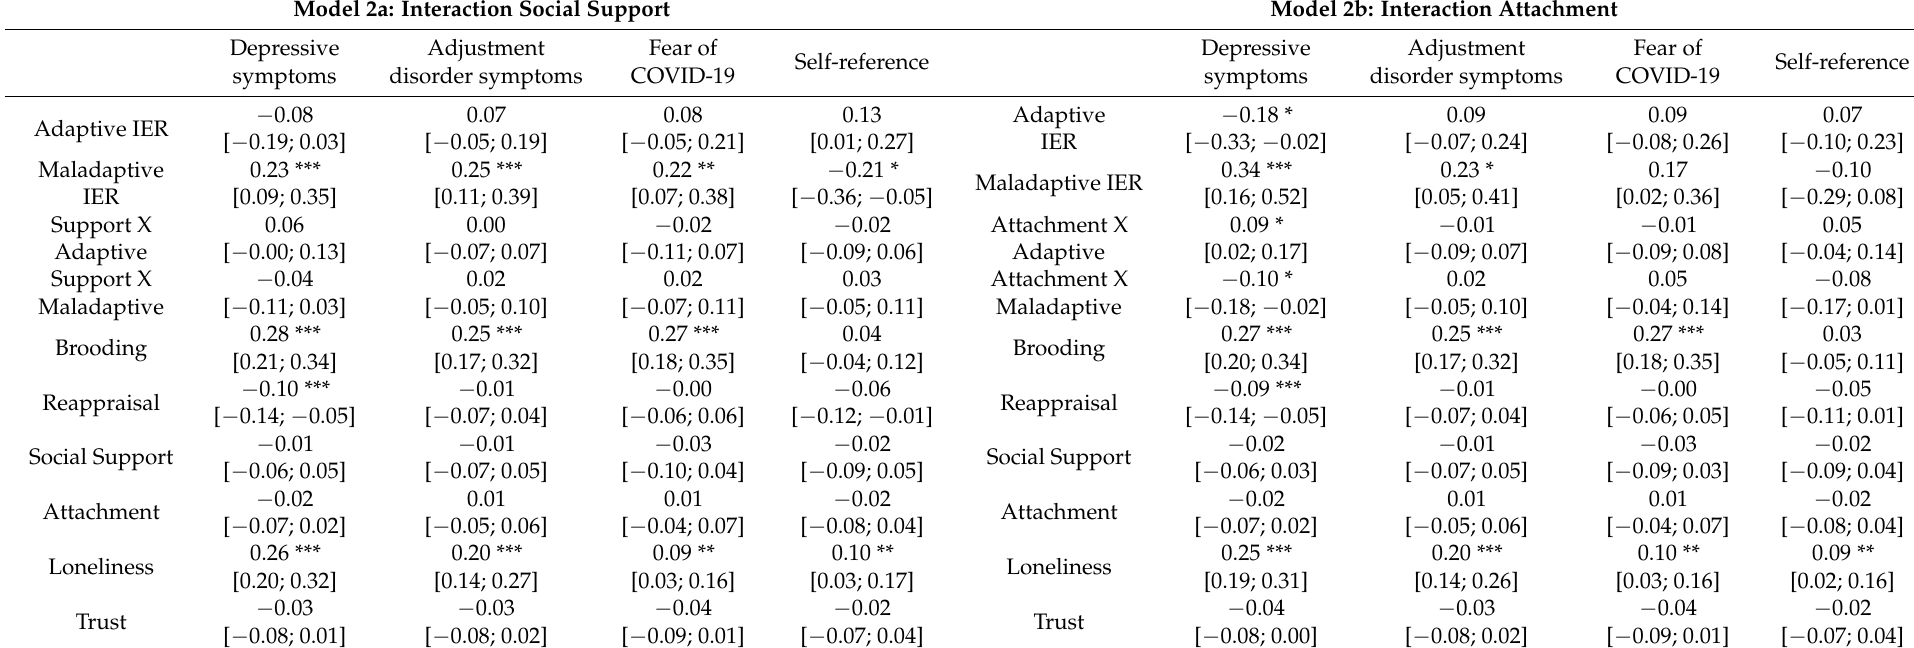
Table 3. Interaction